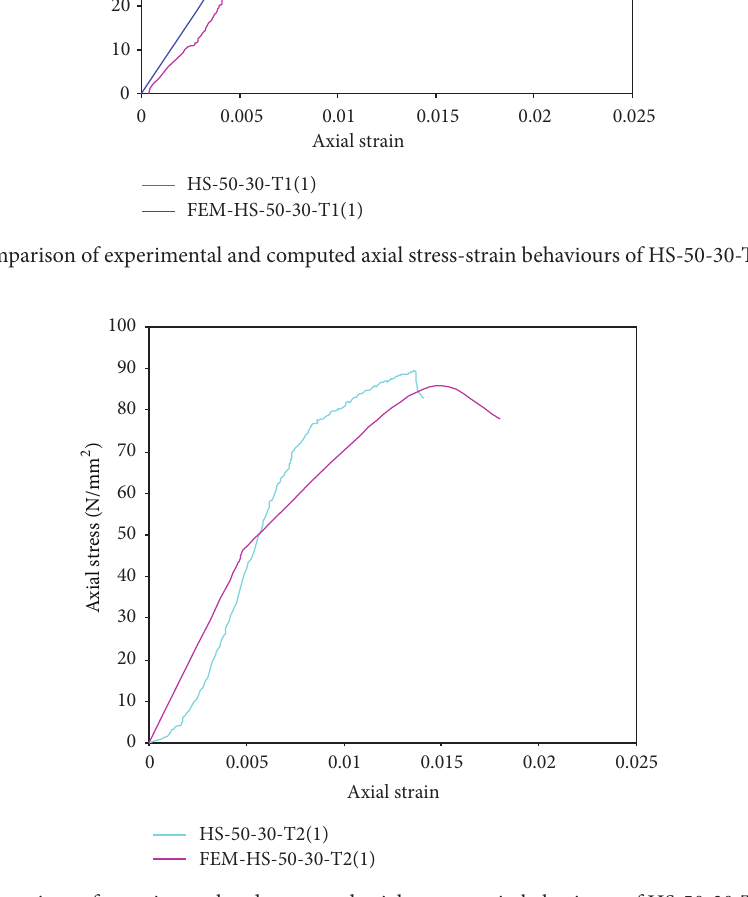
Figure 34: Comparison of experimental and computed axial stress-strain behaviours of HS-50-30-T2 (1)